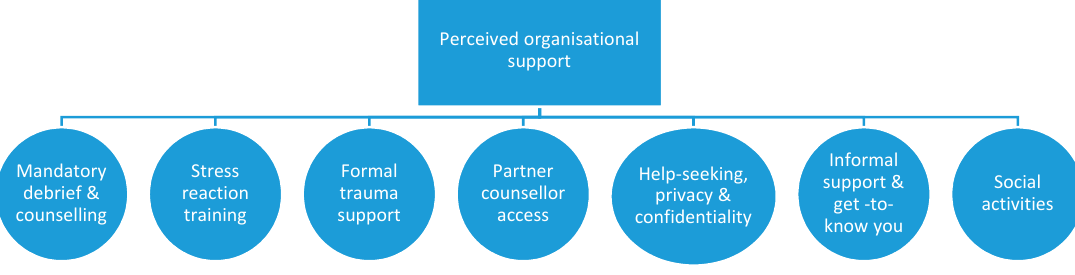
Figure 1. Themes for perceived organisational support.